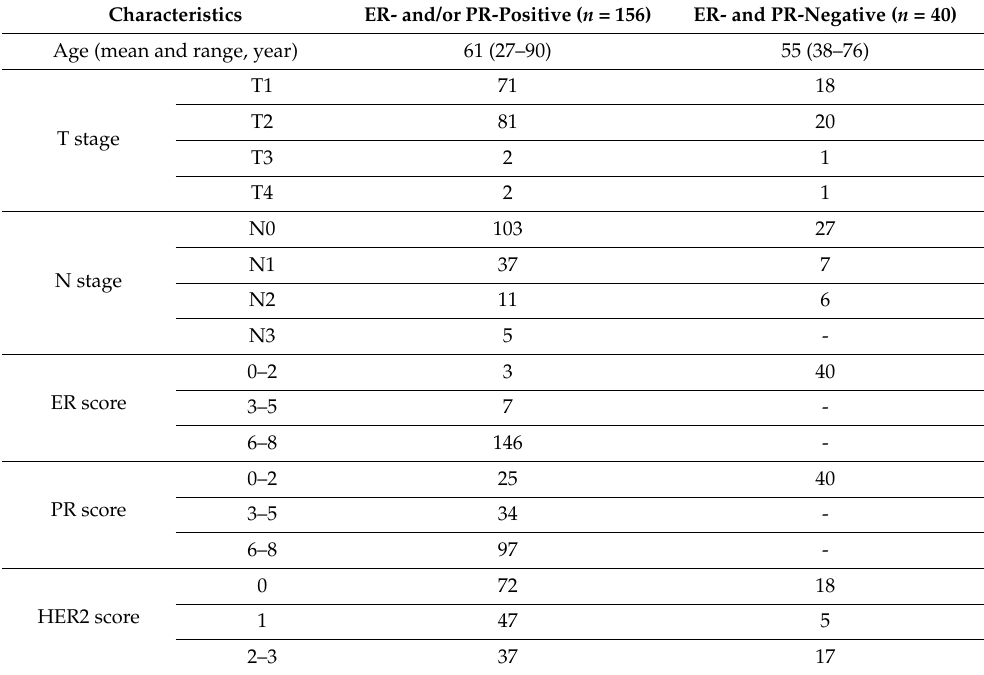
Table 1. Characteristics of the breast tumors under